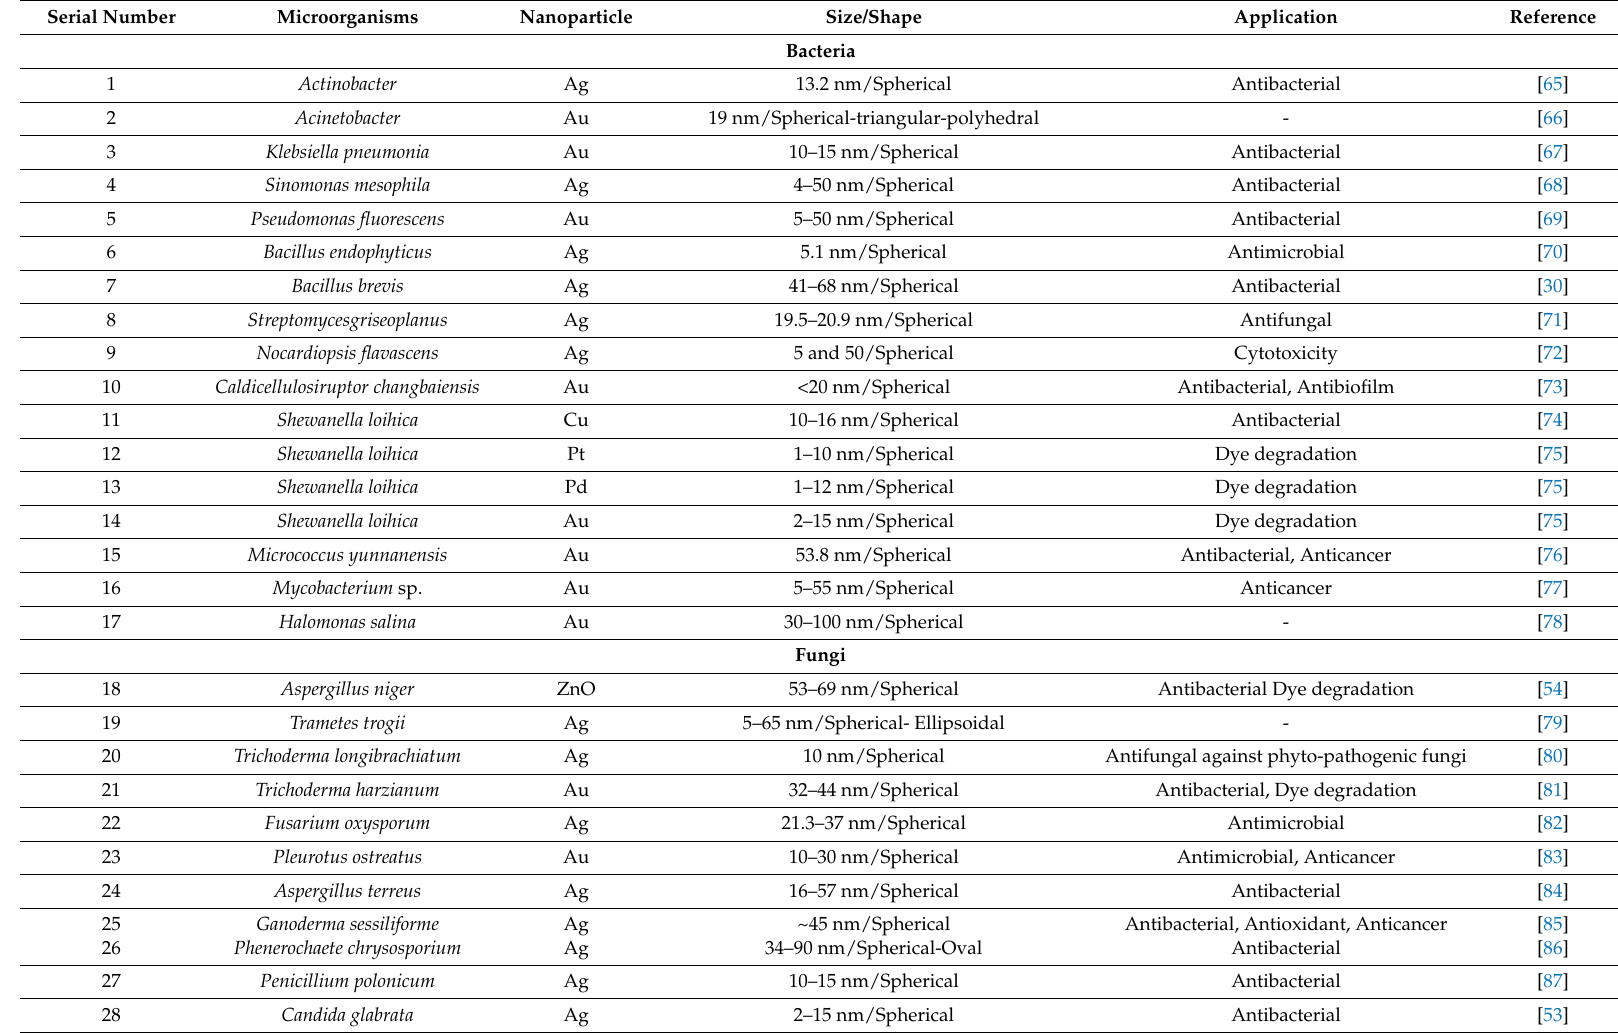
Table 1. Studies from 2016 to date, indicating different microorganisms for nanoparticle